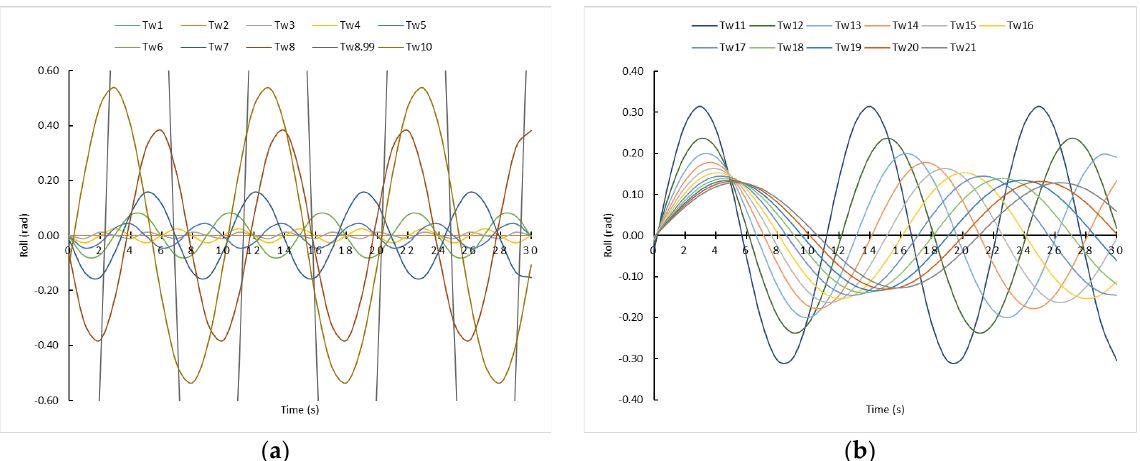
Figure 5. Rolling motion induced by pure beam seas with resistance and with the ship in static and upright positions (Td = 9 s). ( a ) Tw from 1 s to 10 s. ( b ) Tw from 11 s to 21 s.